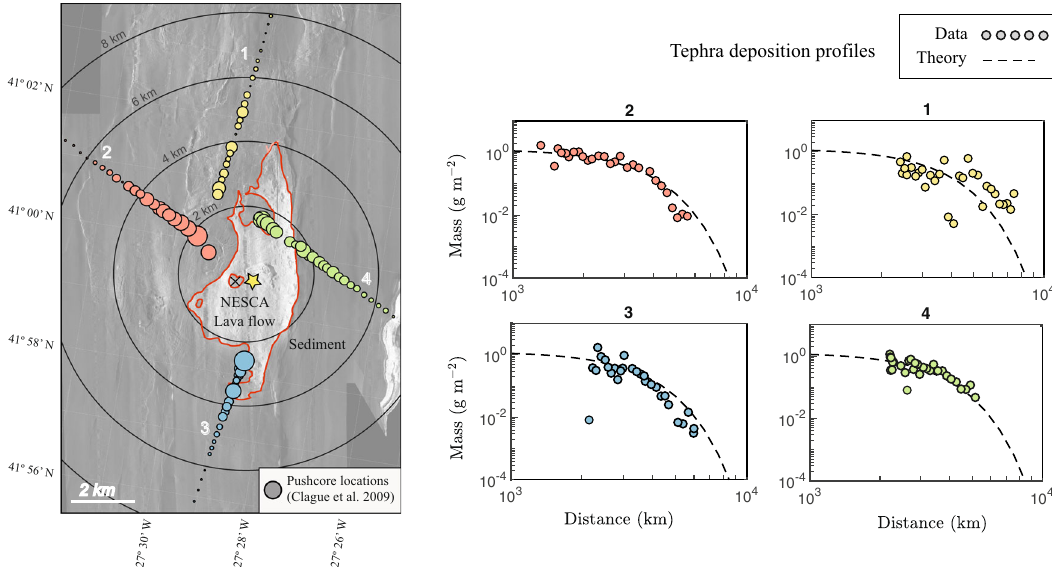
Fig. 2 Map and tephra deposition pattern at the Northern Escanaba (NESCA) eruption site with theoretical fi ts. Sidescan sonar imagery of the Northern Escanaba (NESCA) lava fl ow at the southern end of the Gorda Ridge (see Fig. 1A). Circles show locations of sediment pushcores taken along four pro fi les around the fl ow by 15 , with the area of the data points proportional to the mass per unit area of tephra in the 250 – 500 μ m range. The extent of the lava fl ow is indicated by a red outline. The plots on the right show the mass per unit area of the corresponding sampled data pro fi les (labeled 1 – 4) as a function of distance from an inferred center marked by the yellow star in the map. The inferred center is the unique position creating a global minimum in mean square error resulting from fi tting our Gaussian model given by Eq. (1) to the data. This is ~800 m from the location of the actual eruptive vent, recently identi fi ed using high-resolution bathymetric data (D. Clague, pers. comm.) and shown by the black cross. The Gaussian dispersal pattern resulting from our regression analysis is shown as a dashed curve on each of the plots, for which the dispersal scale L ≈ 4.9 km. The 15% error in estimating the mass of glass particles 15 corresponds to the approximate size of the circular markers. Concentric circles on the map represent 2-km increments from the calculated center. Sonar imagery from 38